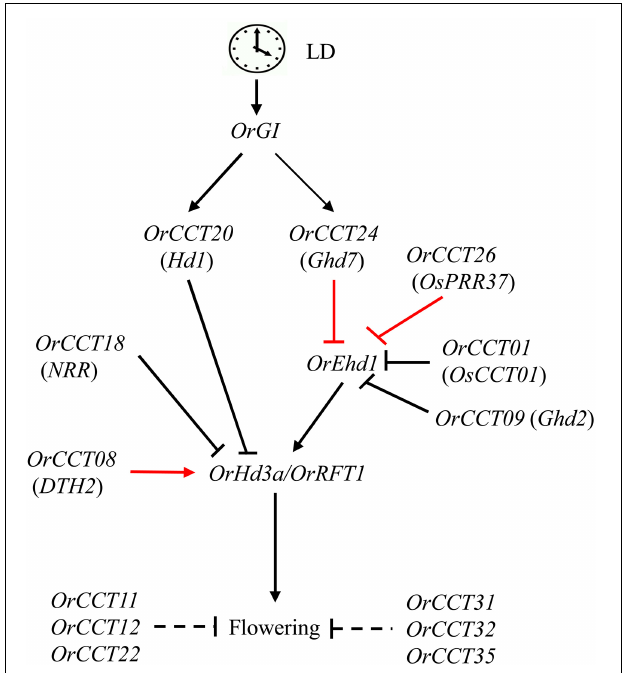
FIGURE 9 | CCT TFs involved regulatory network for flowering time of O. rufipogon under LD. The clock at the top designates the circadian clock. Black arrows represent induction, and black bars indicate suppression. Red arrows show strong induction, and red bars denote strong suppression. The virtual line shows indirect